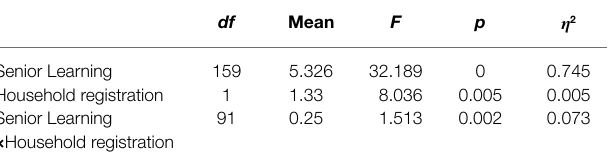
TABLE 9 | Interaction effect analysis.